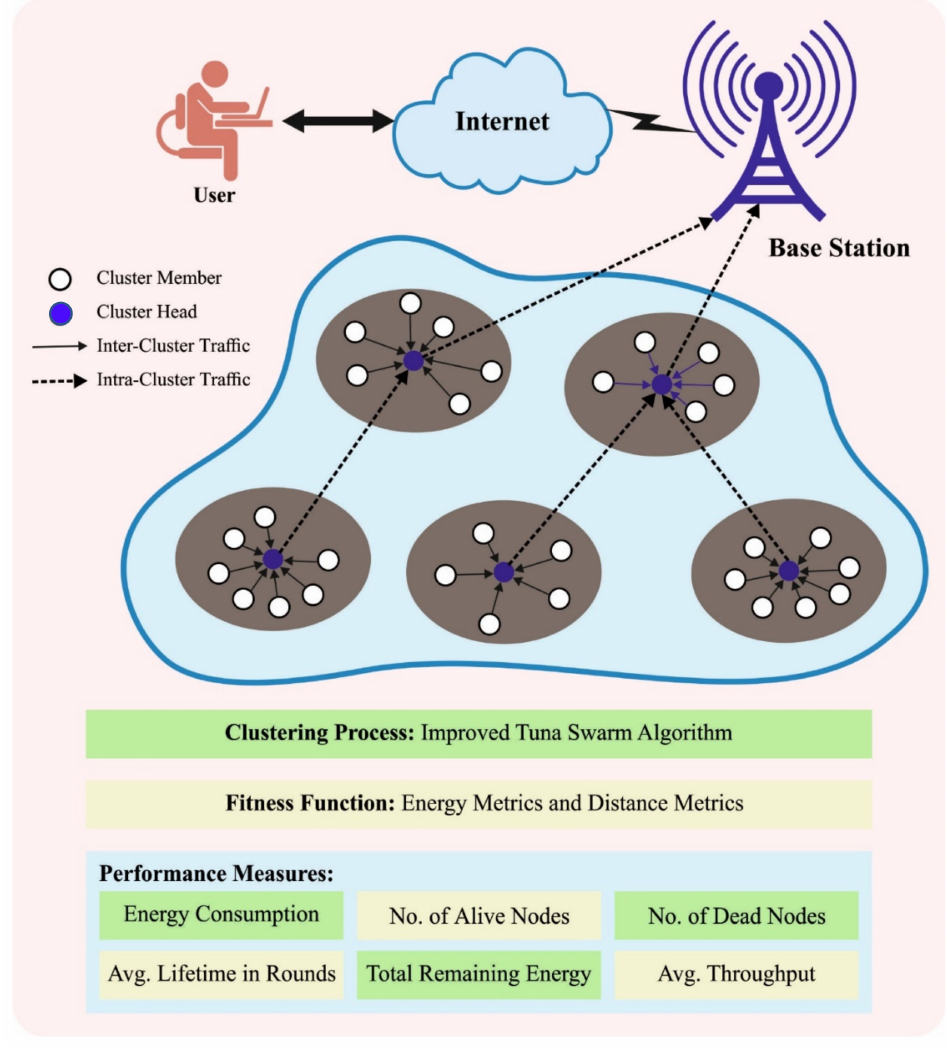
Figure 1. Overall procedure of ITSA-UCHSE